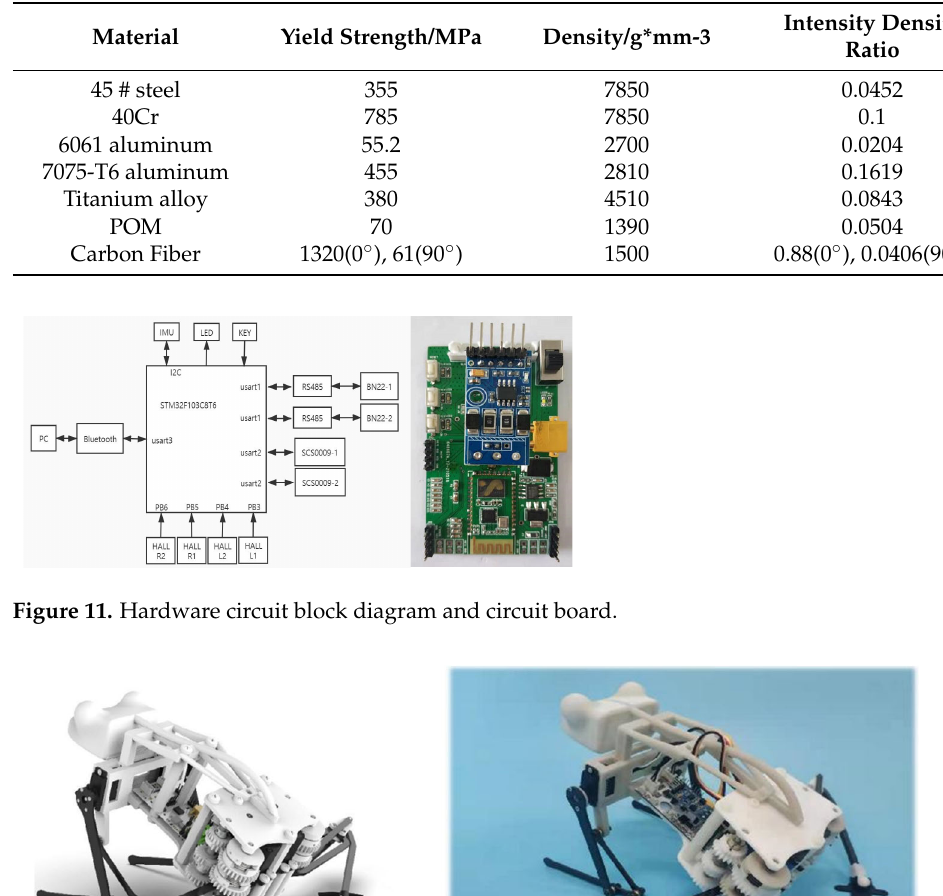
Table 4. Performance parameter table of processing materials.